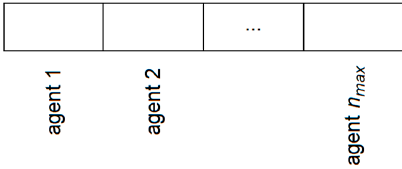
Figure 2. The structure of an input vector. The vector is divided into n max blocks, each block corresponding to an agent.